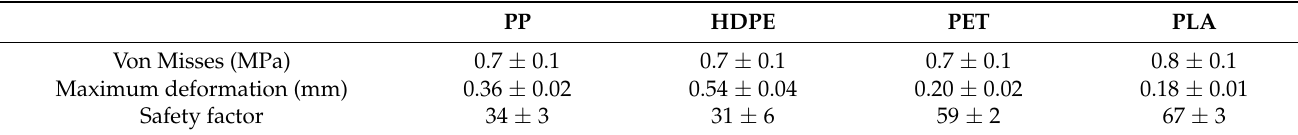
Table 8. Results for the second simulation for commercial